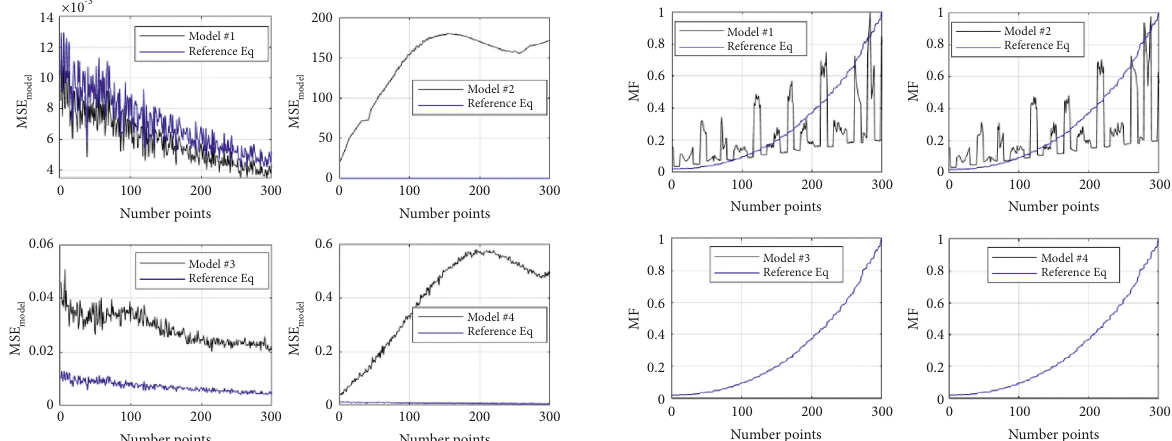
Figure 7: Plots of MSE and MF for the models of Table 1 in Section